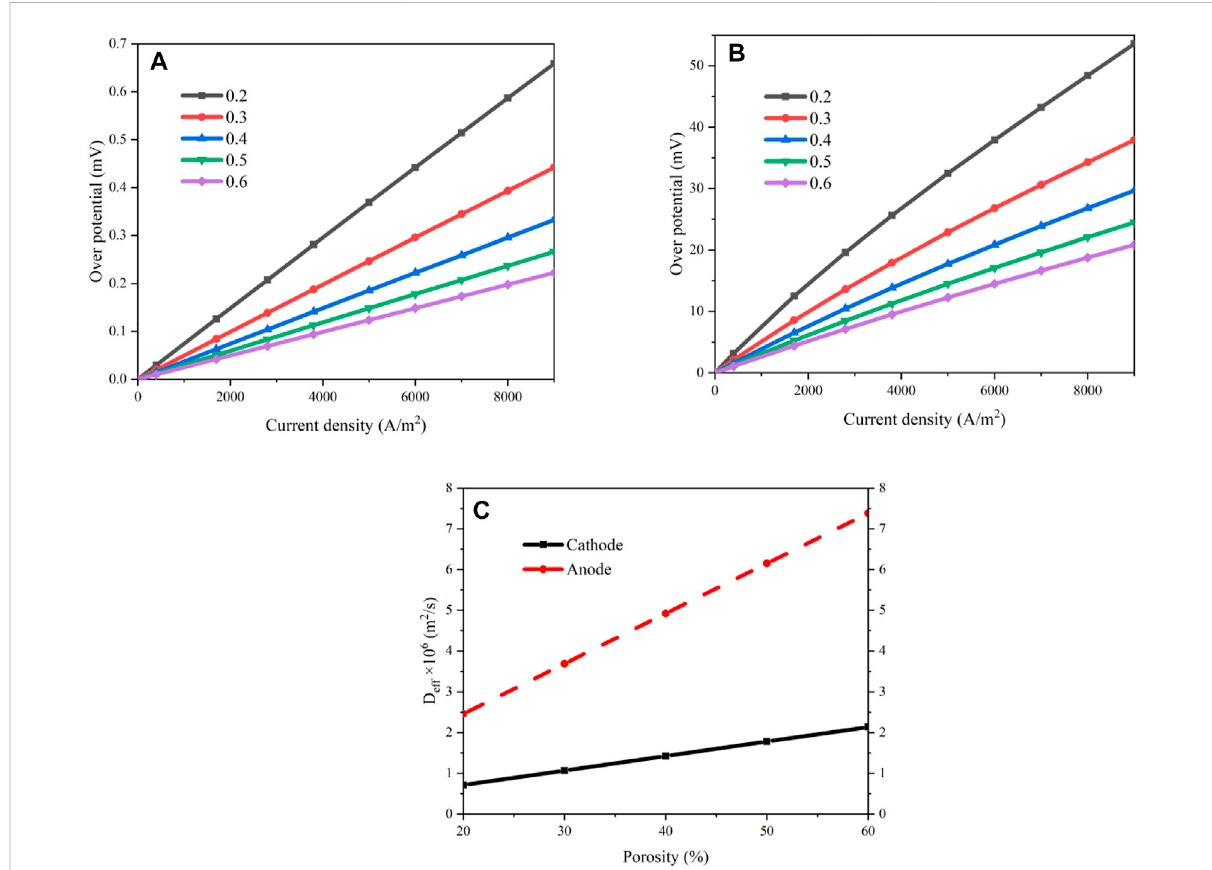
FIGURE 5 Results of the concentration losses under various porosities: (A) overpotential of the anode; (B) overpotential of the cathode; (C) effective diffusion coef fi cients of the